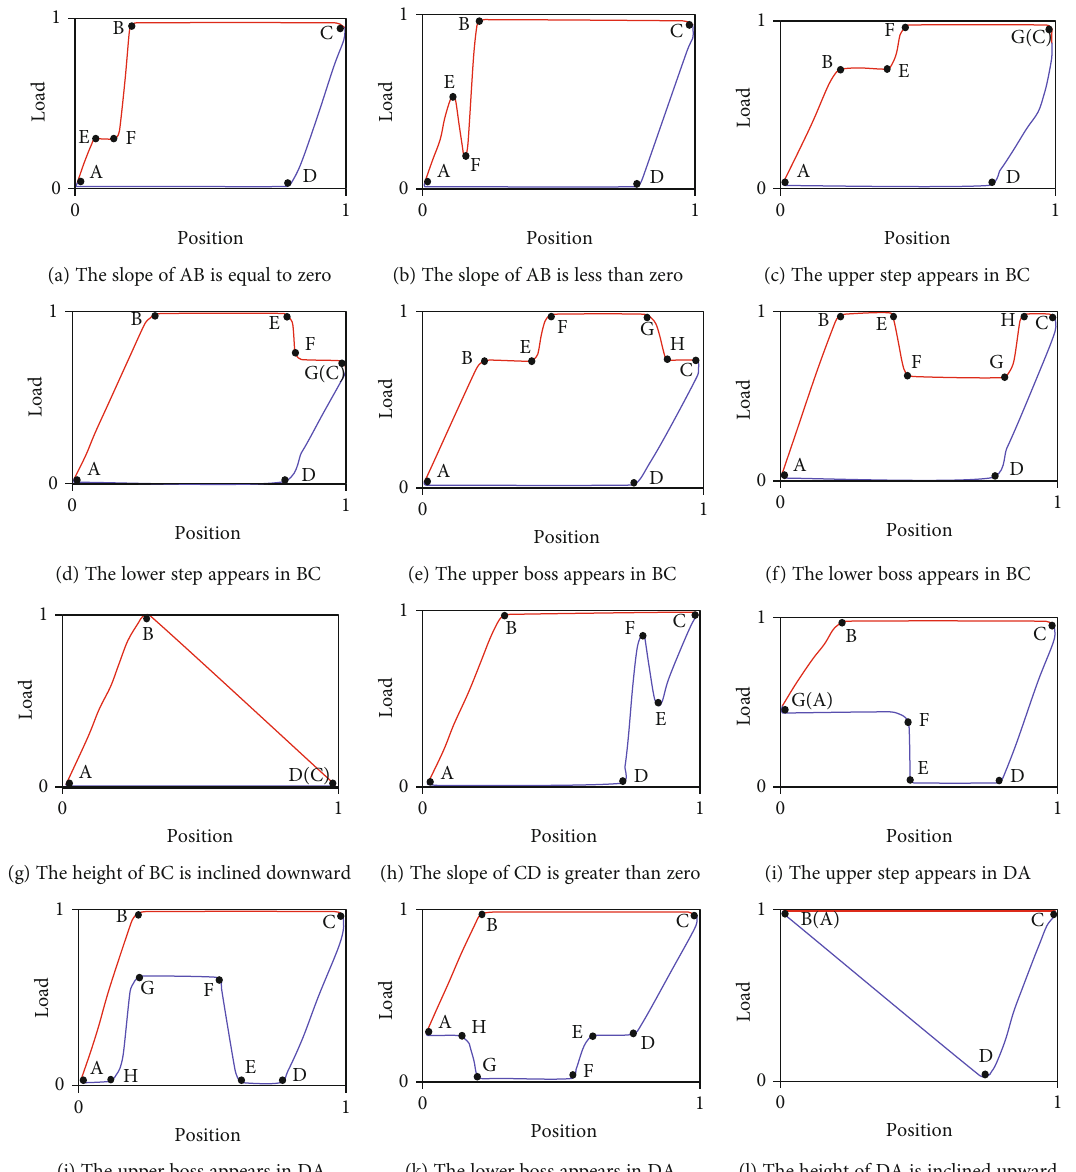
Figure 1: Plate of abnormal dynamometer